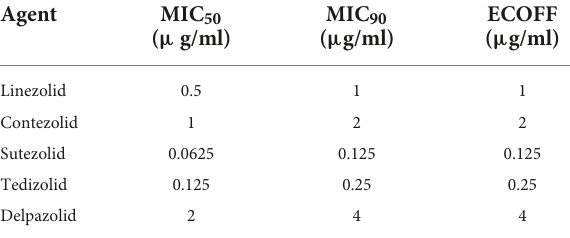
TABLE 2 MICs of the 5 oxazolidinones against 69 Mtb clinical